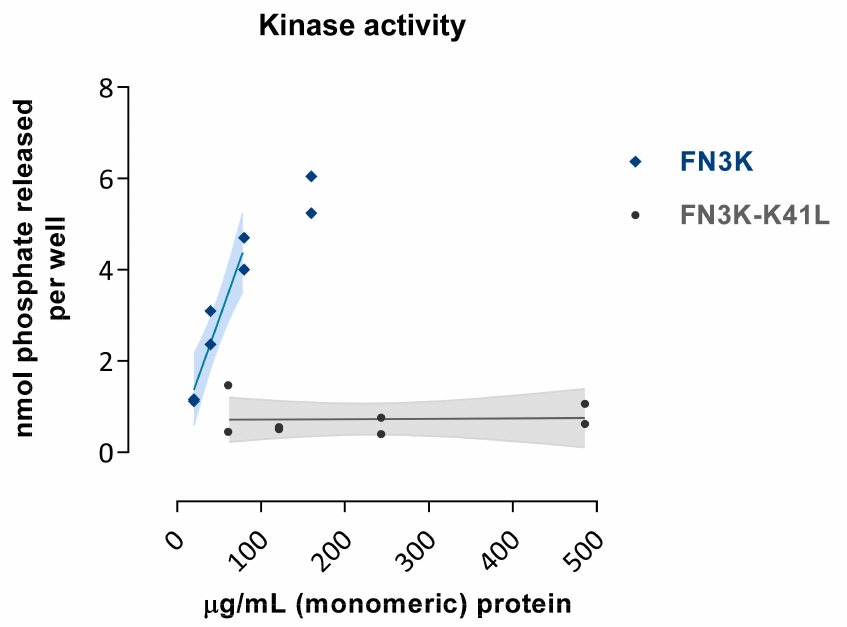
Figure 2. Kinase activity of FN3K and the inactive mutant enzyme FN3K–K41L as assessed by the amount of phosphate released per well (nmol) using a 1-deoxy-1-morpholino-D-fructose (DMF) acceptor substrate at increasing enzymatic concentration levels ( µ g/mL). Data are depicted as single data points with their fitted regression line in the linear range and 95% confidence interval.